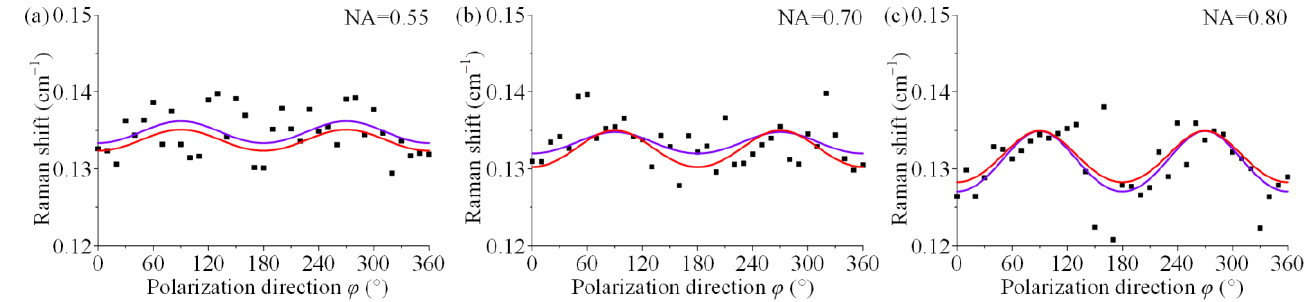
Figure 5. Experimental results of sample 2 with different NAs: ( a ) NA = 0.55, ( b ) NA = 0.70, ( c ) NA = 0.80, where black solid points are experimental data points, the red curve is the theoretical result, and the purple curve is the fitted result.